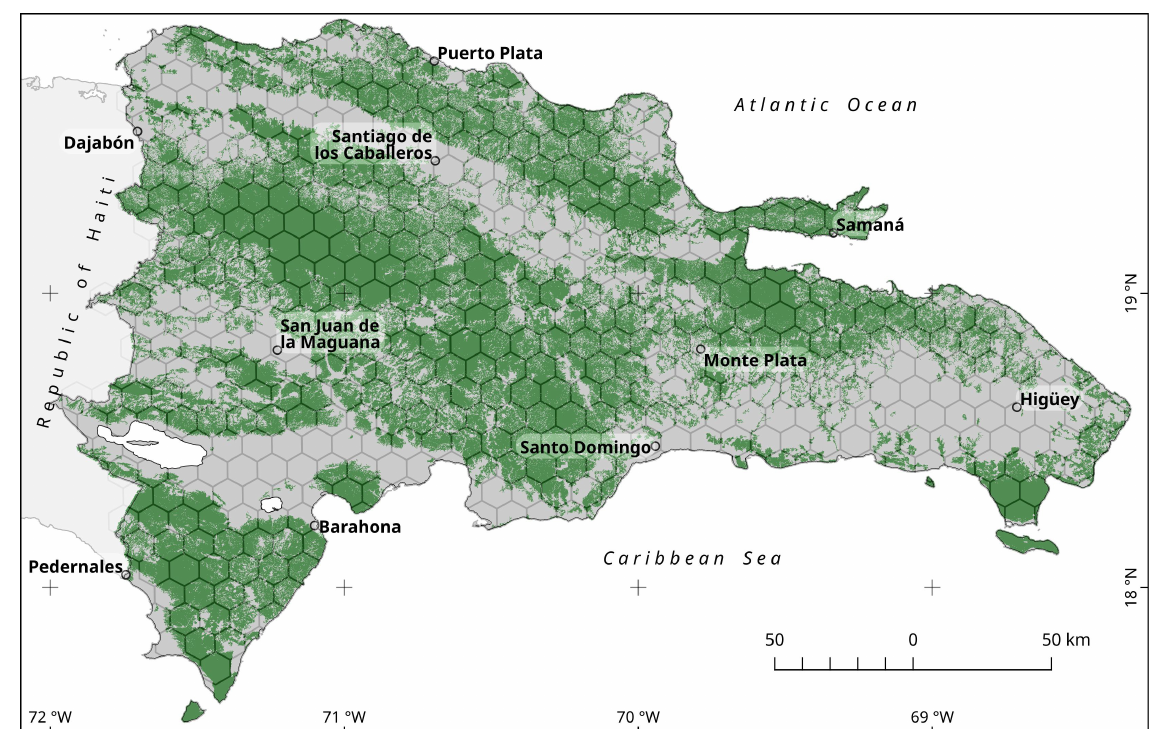
Figure 3 – DR forest cover in the year 2000. Areas with a canopy closure equal to or greater than 25% in tree cover map of MC Hansen et al. (2013) were classified as forest. The hexagonal grid overlaid was used for zonal statistics computations of the long-term approach. See text for